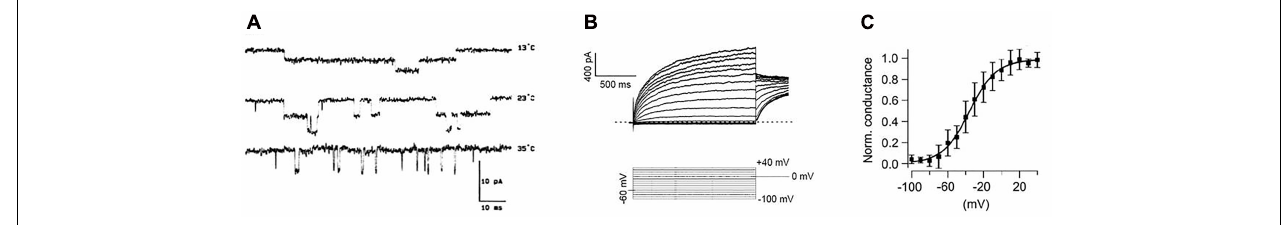
FIGURE 1 | Examples of experimental “patch-clamp” registrations of ion currents. (A) Single-channel currents (downward swings) through acetylcholine receptors at different temperatures [from Dilger et al. (1991) with permission by “Elsevier”]. (B) Voltage-dependent whole cell currents (top) in response to voltage steps to different membrane potentials (bottom). (C) Curve of the voltage-dependent activation of ion channels plotted as normalized conductivity (measured current related to maximum current). Mean values of repeated measurements are plotted together with the standard deviations and fitted to a Boltzmann function (solid line) [Figures 2B,C from Leitner et al. (2012) with permission by “John Wiley and Sons”].